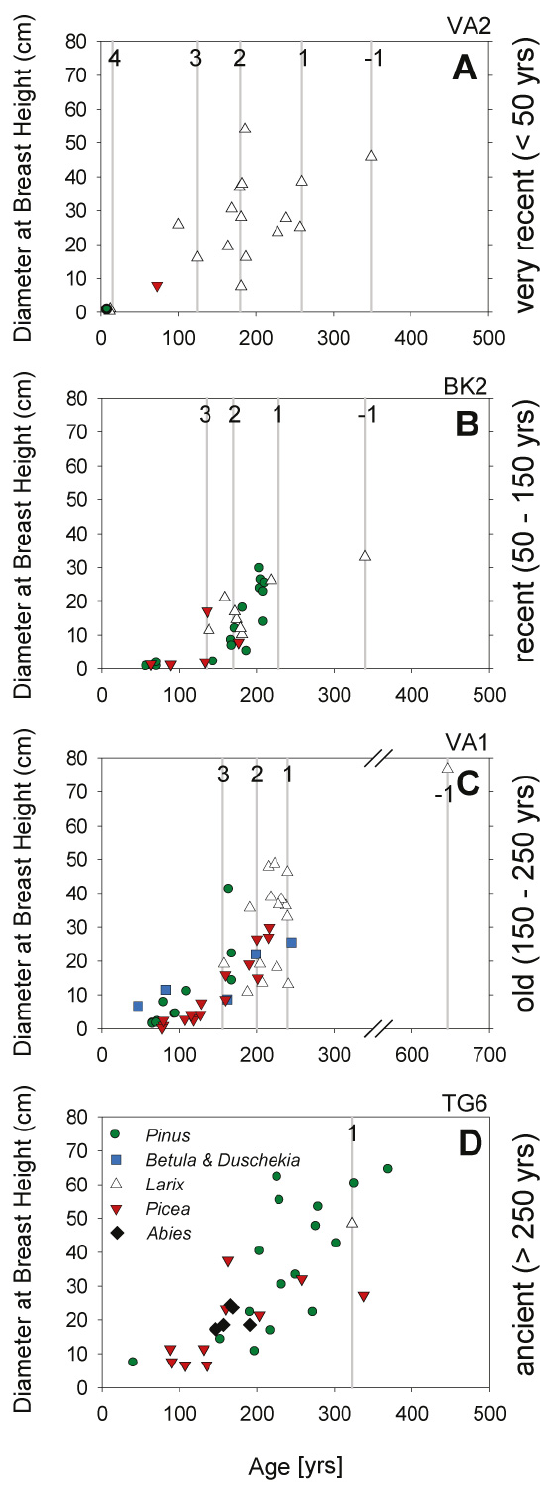
Fig. 3. Diameter at breast height as related to tree age along the Tunguska